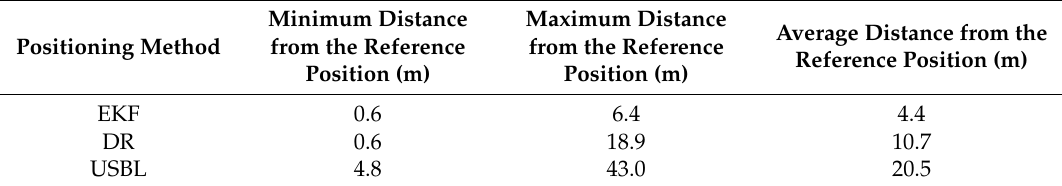
Figure 32. Histogram of the reference position distance from the position estimated by EKF and DR methods and determined by the USBL system (one hundred passages). Table 12. Statistical parameters of positioning errors using EKF, DR methods and the USBL system (one hundred